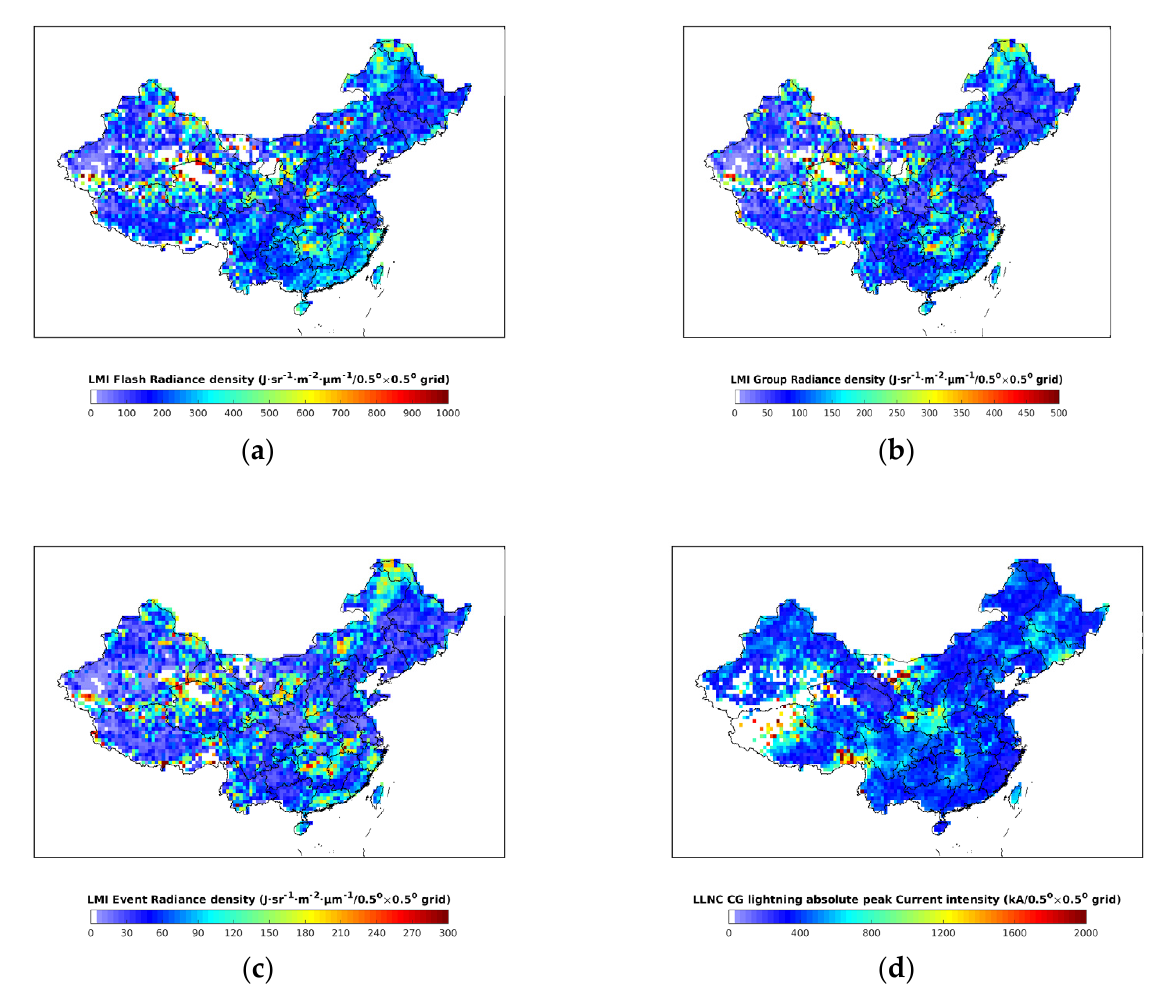
Figure 3. Spatial distribution of lightning radiance observed by the FY-4A LMI and peak current of LLNC CG Event in July 2019. ( a ) LMI Flash, ( b ) LMI Group, ( c ) LMI Event, and ( d ) LLNC CG Event. The current polarity is not taken into consideration.